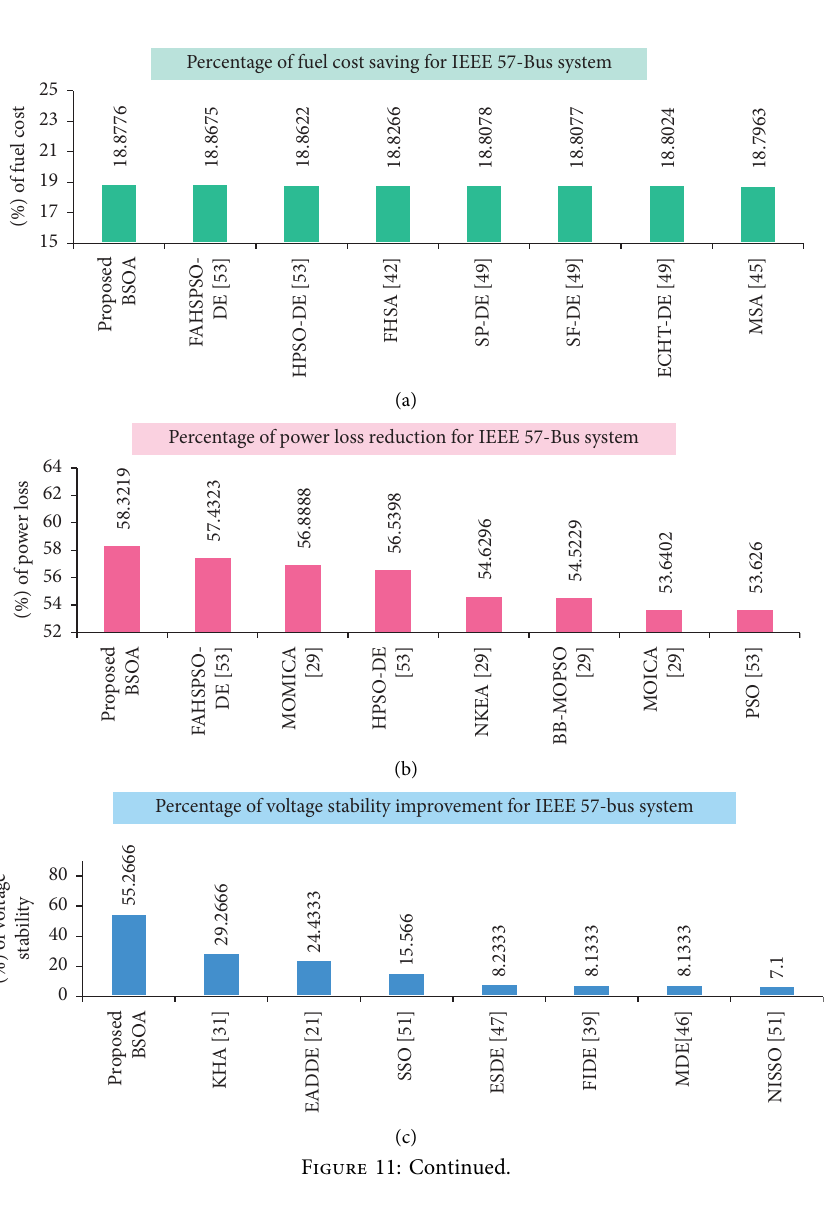
Figure 10: Convergence characteristic curves for single-objective OPF (Case 17 through Case 21) of the IEEE 57-bus system: (a) Case 17; (b) Case 18; (c) Case 19; (d) Case 20; (e) Case